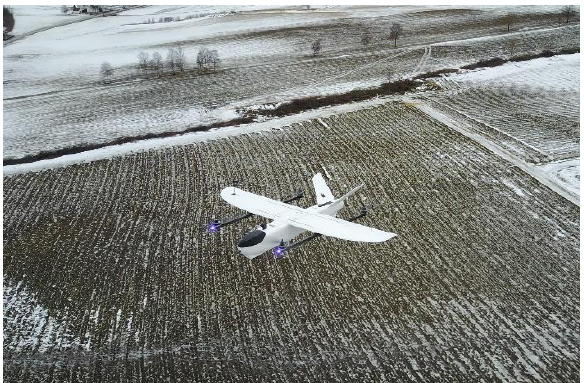
Figure 2. Hybrid UAV with enhanced rotary-wing capabilities, hovering 50 m AGL over the test location at Apelsvoll research station (image taken from a multi-rotor